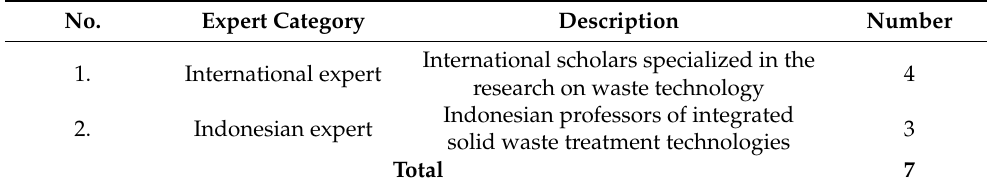
Table 5. Expert category.